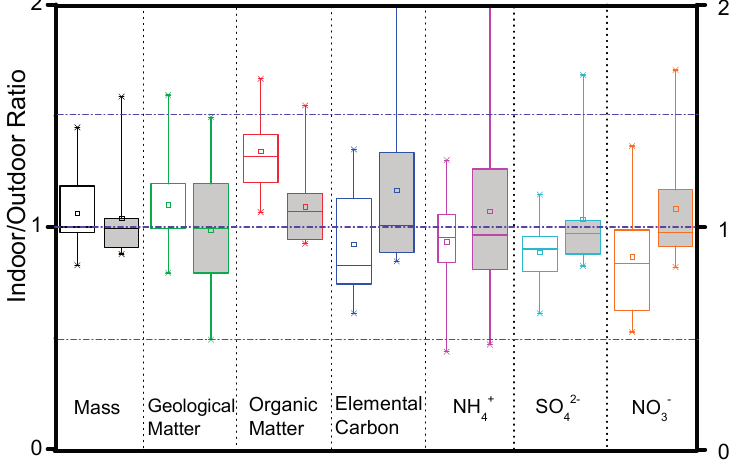
Figure 6. I/O ratios for PM 2.5 mass and its major components during the summer (empty boxes) and winter (shade boxes) campaigns in 2013.